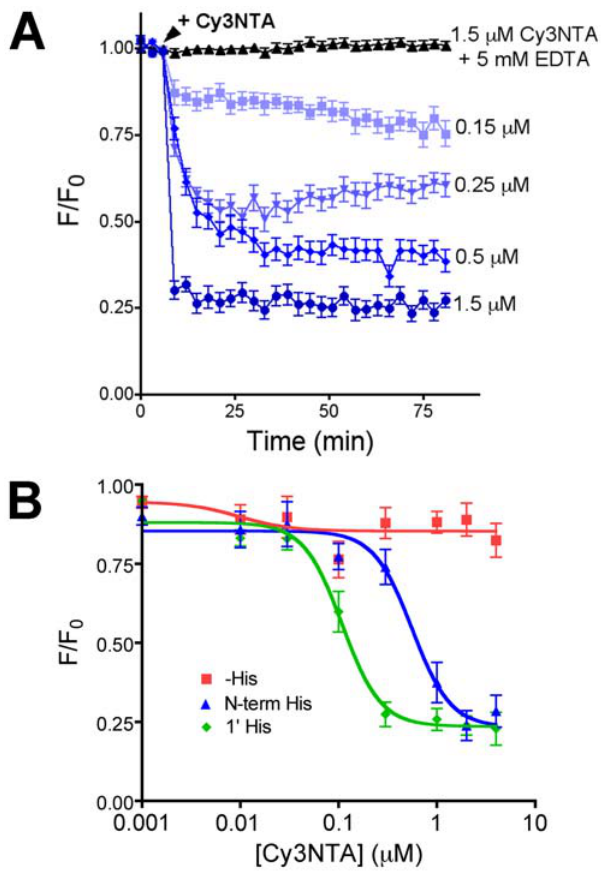
Figure 6. Cy3NTA quenches His-tagged GFP-RyR1 fluorescence in a concentration-dependent manner. (A) Concentration depen- dence of Cy3NTA quenching of GFP-RyR1 (N-term His) fluorescence. The indicated Cy3NTA concentrations were added to HEK-293T cells expressing GFP-RyR1 (N-term His) at the time point indicated (arrowhead) and the change in GFP fluorescence normalized to initial fluorescence (F/F 0 ) was measured. Pre-incubation with 5 mM EDTA (top trace) abolished fluorescence quenching by Cy3NTA. (B) Cy3NTA concentration dependence of quenching of the indicated GFP-RyR1 fusion proteins expressed in HEK-293T cells. Values represent mean + / 2 S.E.M. for 7–14 cells. EC 50 and FRET efficiency values were determined from these curves as described in Methods.